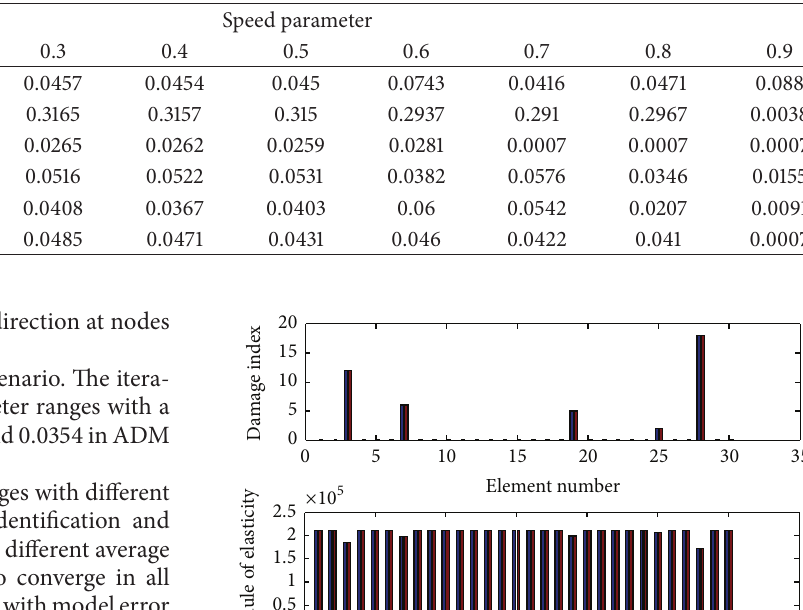
Table 2: RPE of DDM method for model 1.